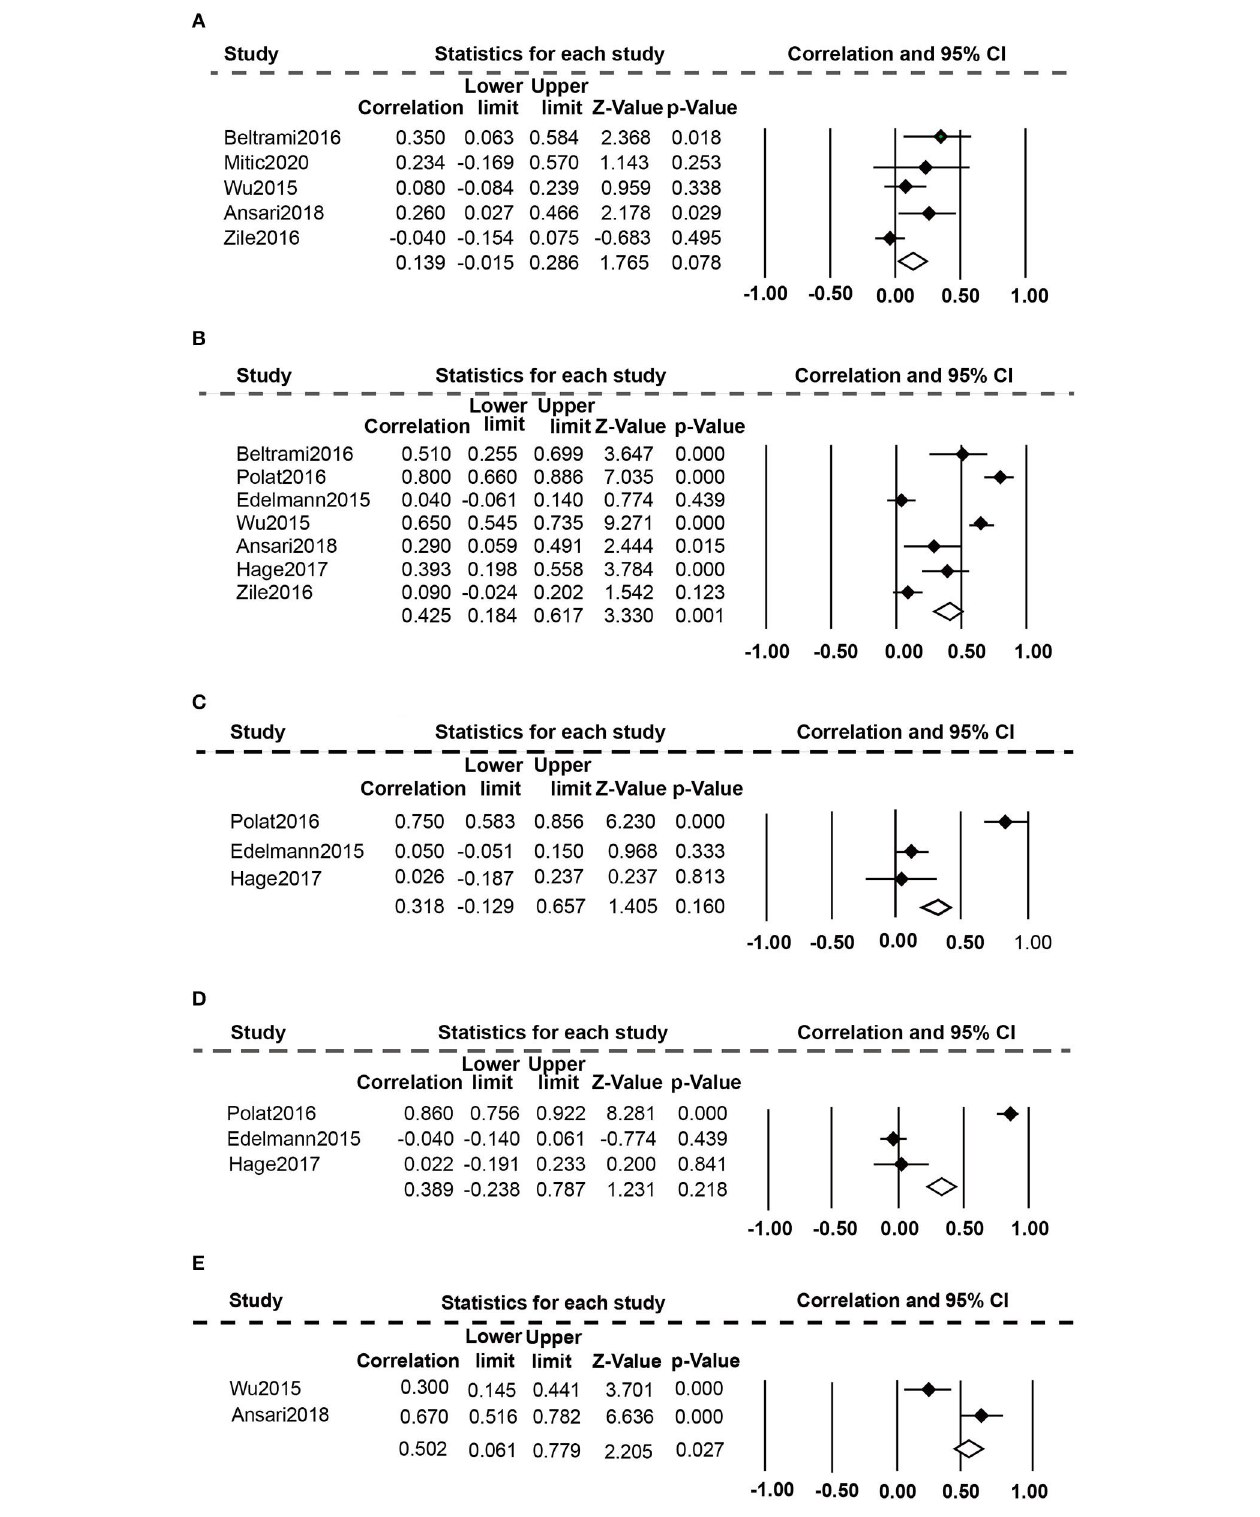
FIGURE 4 | Association between elevated plasma Gal-3 levels and echocardiographic parameters: (A) Association between plasma Gal-3 and E/A. (B) Association between plasma Gal-3 and E/e. (C) Association between plasma Gal-3 and LAVI. (D) Association between plasma Gal-3 and LVMI. (E) Association between plasma Gal-3 and